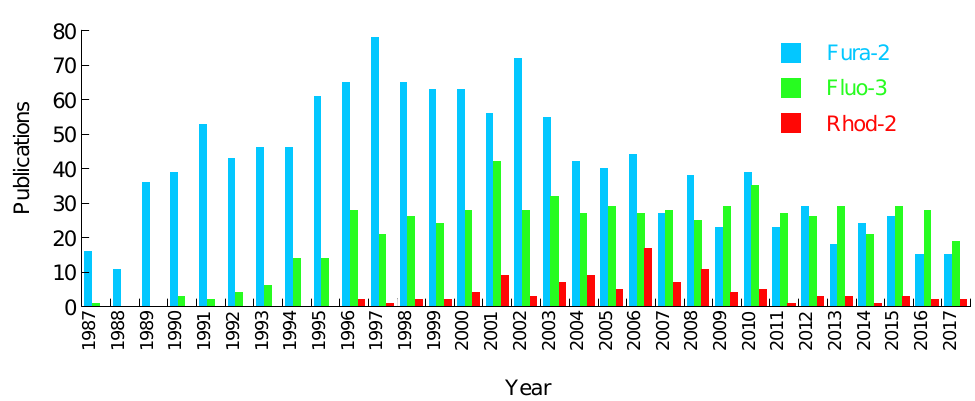
Figure 1. Annual publications imaging cardiomyocytes or heart tissue using the fluorescent Ca 2+ indicators fura ‐ 2, fluo ‐ 4, and Rhod ‐ 2. Metrics extracted from CSV data at Pubmed. Advanced applications, for example, the measurement of free and myofilament bound Ca 2+ in intact cardiomyocytes, can be achieved using chemical Ca 2+ indicators in combination with a simultaneous voltage clamp. The first step of these protocols requires intracellular Ca 2+ to be revealed either by a calibrated fura2 transient or the intensiometric signal of fluo4, which can be calibrated by mechanical disruption of the plasma membrane at the end of each experiment to obtain the maximum fluorescence (F max ) relative to the external Ca 2+ concentration. In the second step, estimates of free Ca 2+ are plotted against total intracellular Ca 2+ , determined by the calculation of the Sodium Calcium Exchanger (NCX) integral conferred by changes in whole cell membrane potential upon the direct application of caffeine, where the difference between free and total Ca 2+ reflects myofilament ‐ bound Ca 2+ [17,19,20].